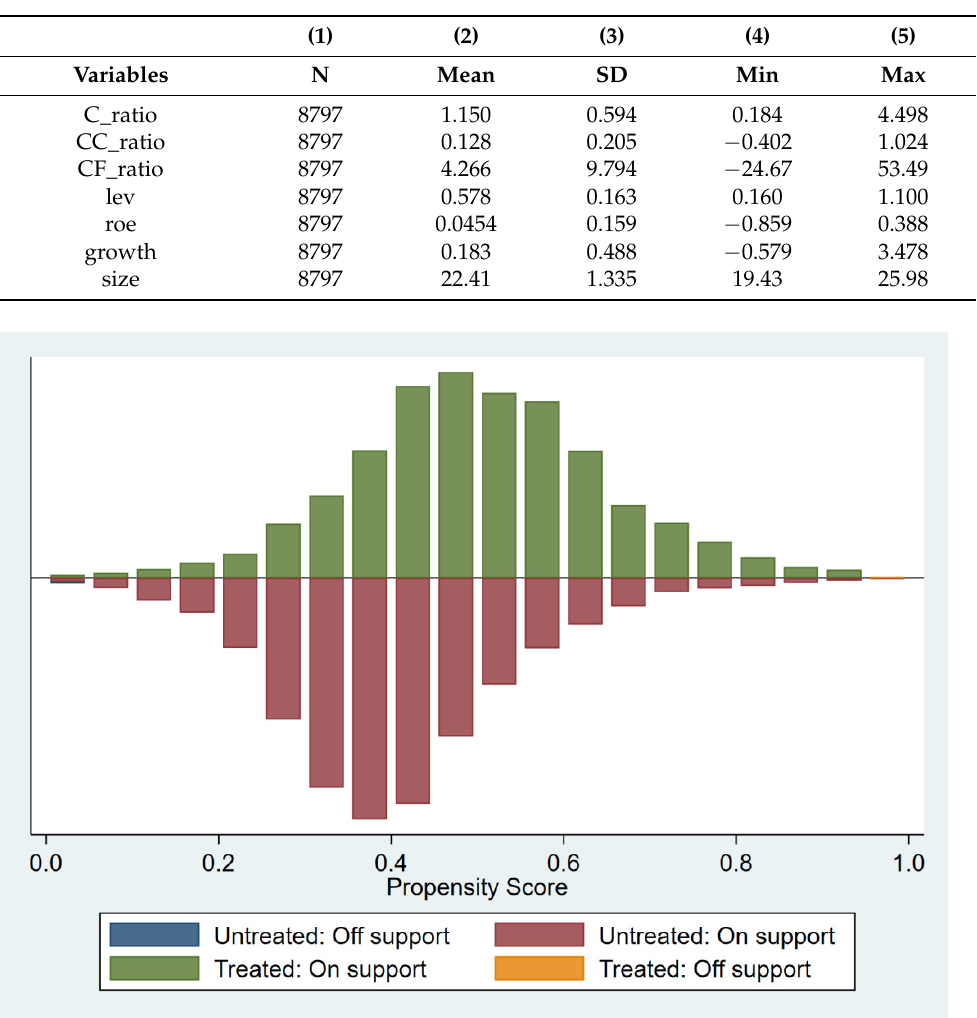
Figure 2. Distribution of the PSM results.